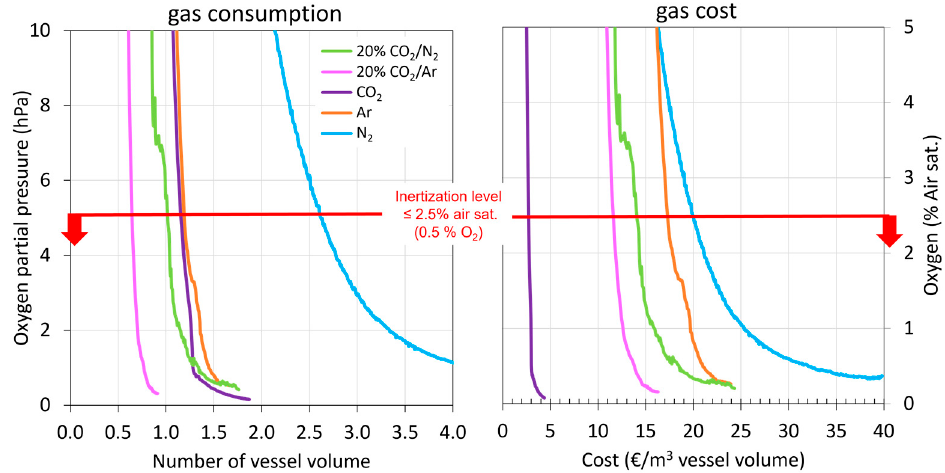
Figure 5. Number of vessel volumes of inert gas required to achieve total inerting and their eco- nomic cost.